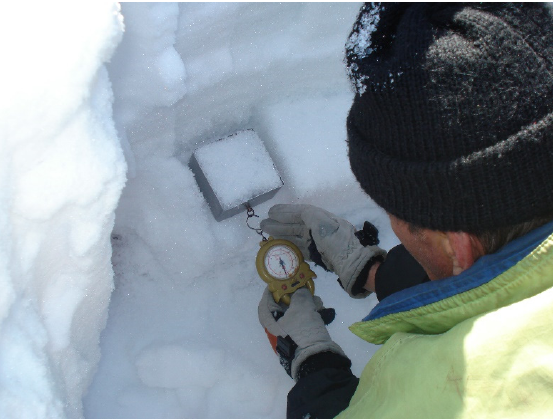
Figure 2. Measuring the shear strength of snow in a weak layer. To characterize the avalanche activity, the data on the size and number of avalanches, based on the results of observations by the avalanche stations and the Institute of Geography and Water Safety was used. The types and reasons of avalanches were determined by the avalanche deposits and were controlled by weather conditions. The sizes of some avalanches were measured instrumentally by geodetic methods, but in most cases, they were visually assessed.